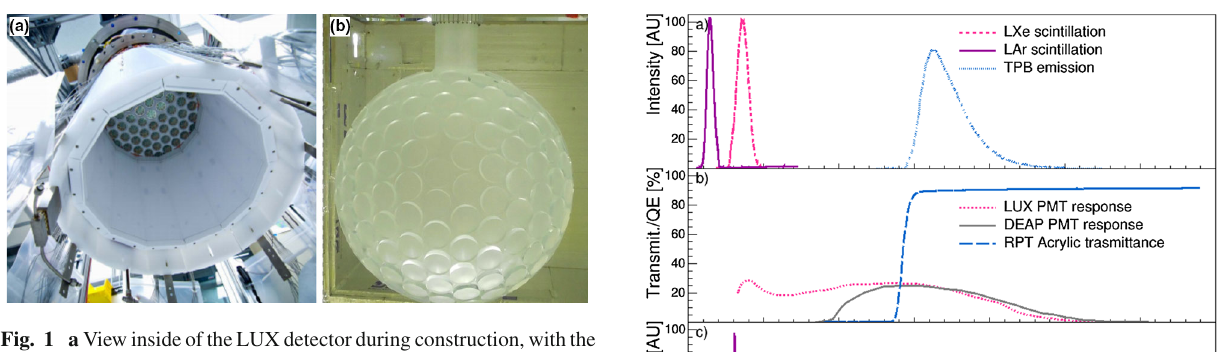
Fig. 1 a View inside of the LUX detector during construction, with the lower PMT array removed. The cylindrical volume is formed by twelve PTFE panels [6]. During operation, the volume is filled with LXe. b Spherical acrylic cryostat ( ∅ 170cm ) used in the DEAP-3600 detector, shown here during construction [2]. During operation, the cryostat is filled with LAr